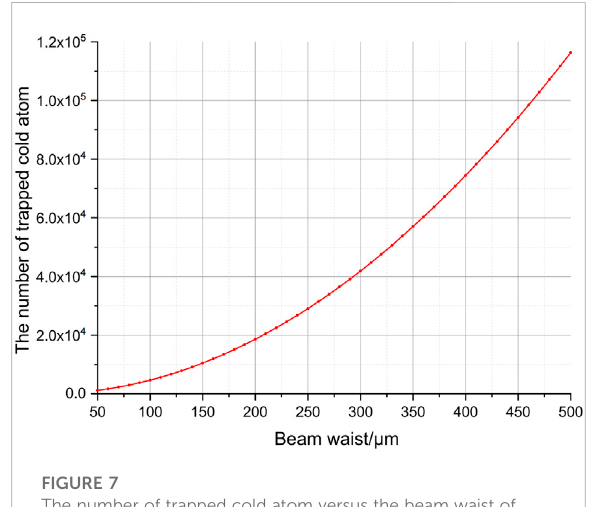
FIGURE 6 Therequiredpowerversusthebeamwaistincaseofpotential well depth U 0 = 20 μ K.